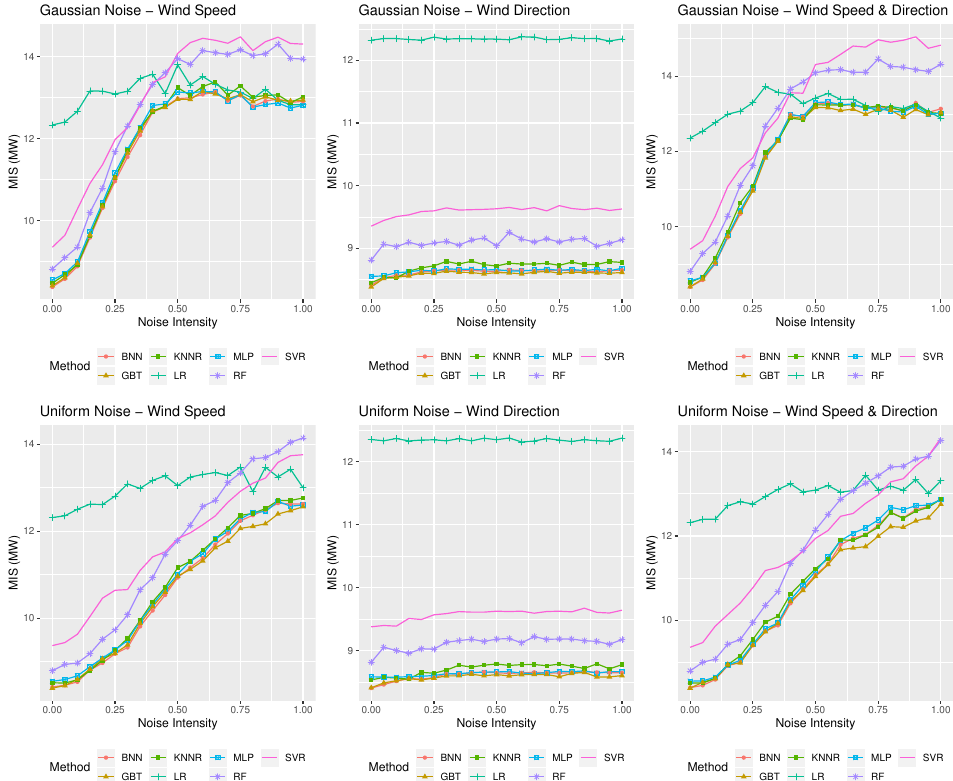
Figure 7. Forecasting performance in terms of wind power prediction intervals (Mean Interval Score (MIS), measured in MW) of the statistical and ML methods considered in this study for the Aeolos wind farm when different types of noise and noise intensities are considered. The three panels on the top display the accuracy of the methods for the case of the Gaussian noise of various intensities, σ , applied to wind speed forecasts, wind direction forecast, and both, respectively. The three panels at the bottom display the same results for the case of the uniform noise of various intensities s